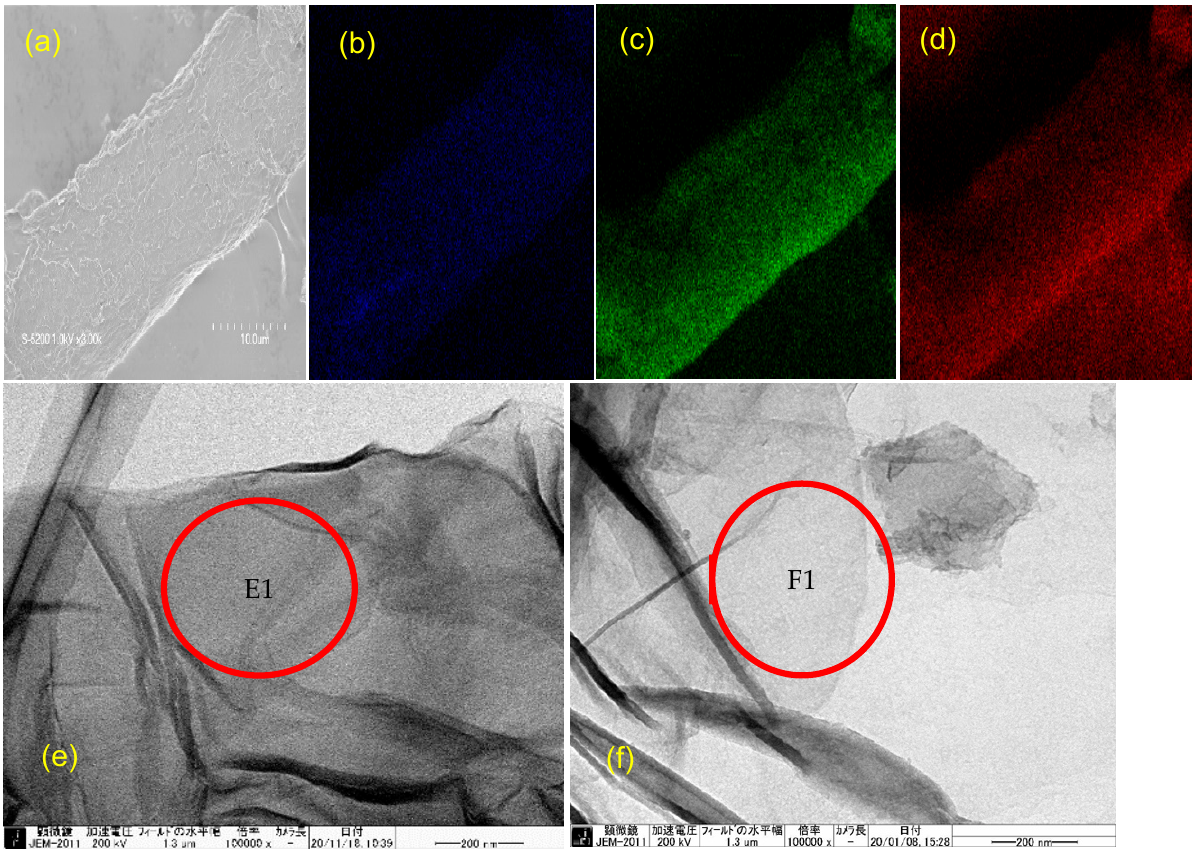
Figure 2. SEM measurement: ( a ) [GO 70 POM] 41 , its EDS map ( b ) Tungsten element, ( c ) Oxygen element, ( d ) Carbon K- α X-ray element; TEM image: ( e ) [GO 70 POM] 41 , ( f ) GOc 70 , showing the formation of a layer after forming the composite [GO 70 POM] 41 ( E1 ) compared with the original GO C70 ( F1 ) in the same-scale image (200 nm).